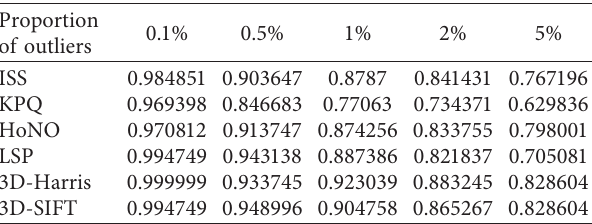
Table 13: The outlier repetition rate r tection algorithm on the Kinect data set. of the key point de- outlier